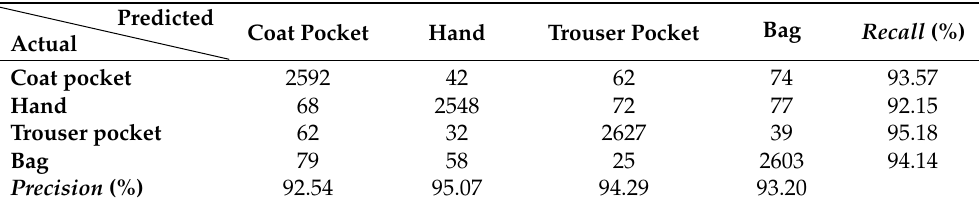
Table 2. Confusion matrix of position